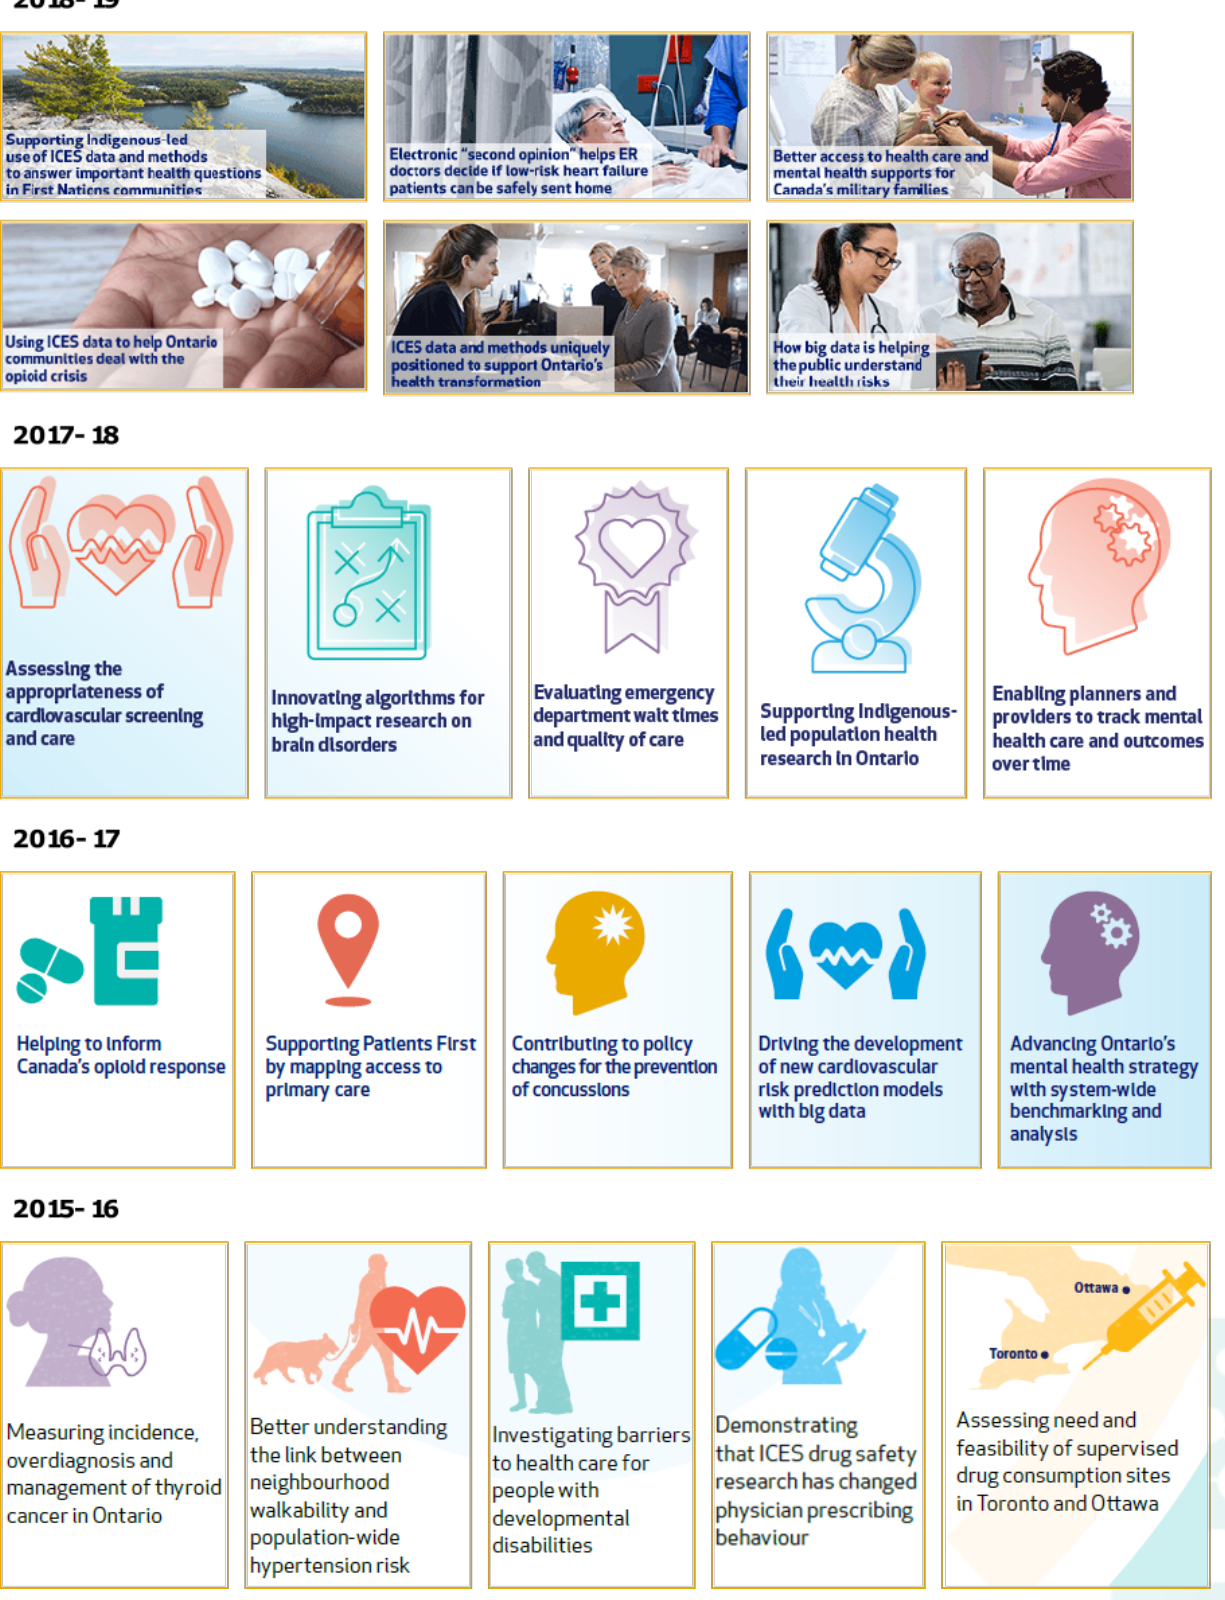
Figure 2: Examples of ICES Research Impact